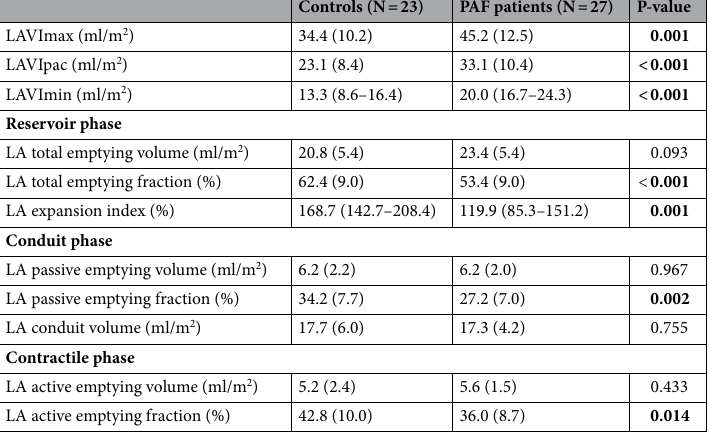
Controls (N = 23) PAF patients (N = 27)